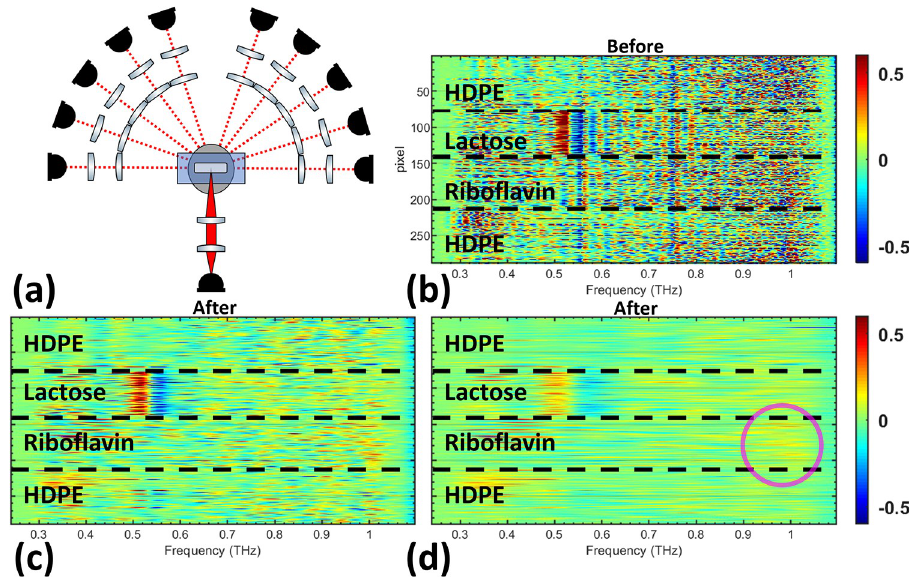
Fig 9. Diffuse angle measurements from θ ( ± 1 to ± 5) . (a) The optical configuration used in Fig 9 ( θ ( ± 1 to ± 5) ) is shown. The derivative spectra of the pixels are shown (b) before filtering and after the signal has been filtered using the (c) lactose Gaussian bandpass filter and the (d) riboflavin Gaussian bandpass filter.